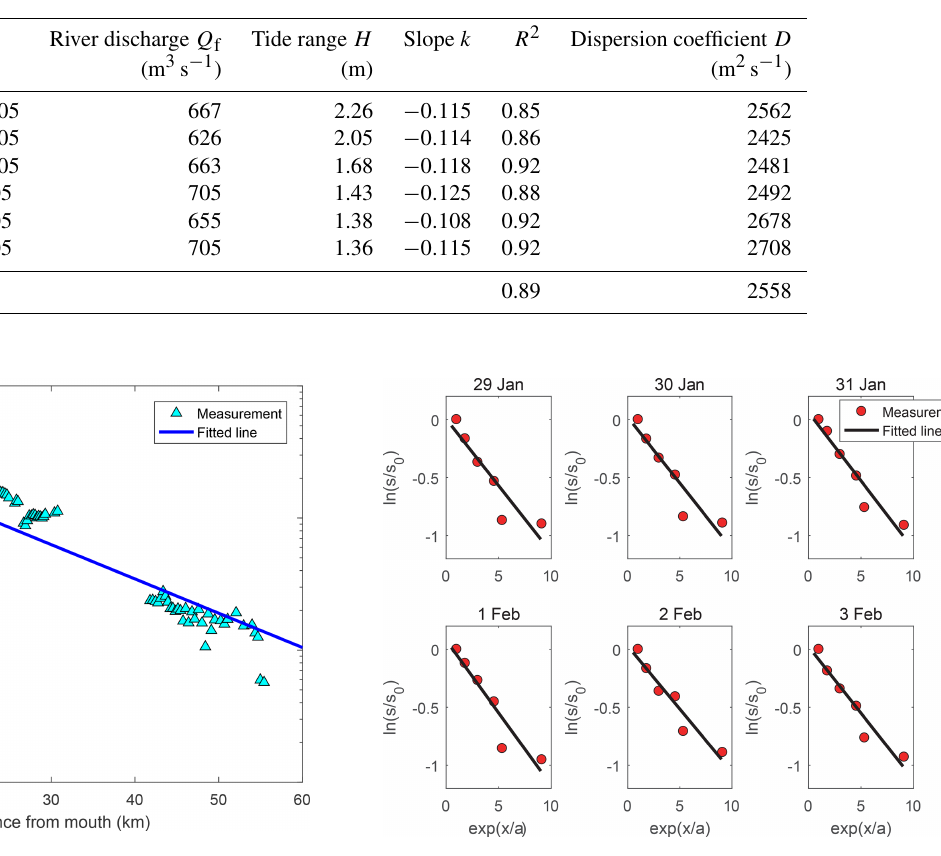
Figure 2. Shape of the Humen estuary, showing the correlation be- tween the cross-sectional area A (m 2 ) and the distance from the estuary mouth x (km). The coefficient of determination R 2 is 0.92. The triangles represent observations, and the line represents the fit to Eq. (1), where the area at the estuary mouth is A 0 = 37822m 2 and the area convergence length ( a ) is 16.7km. Table 3. Calibrated values of parameters.